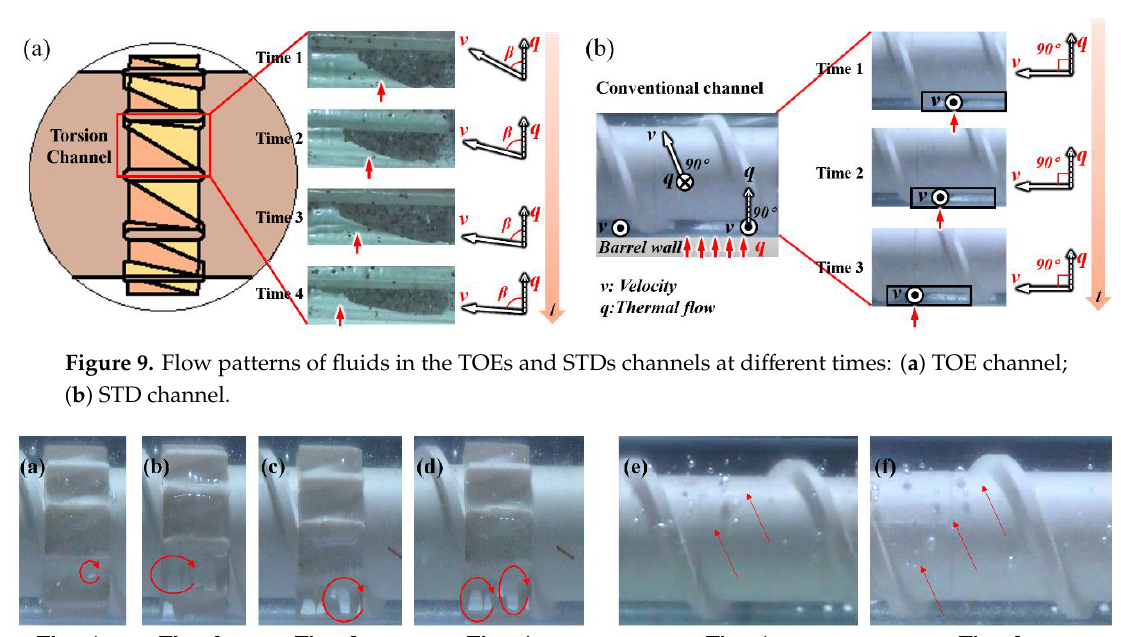
Figure 8. Visualization test stand: general view of extruder with visualization feature used in the experiments.